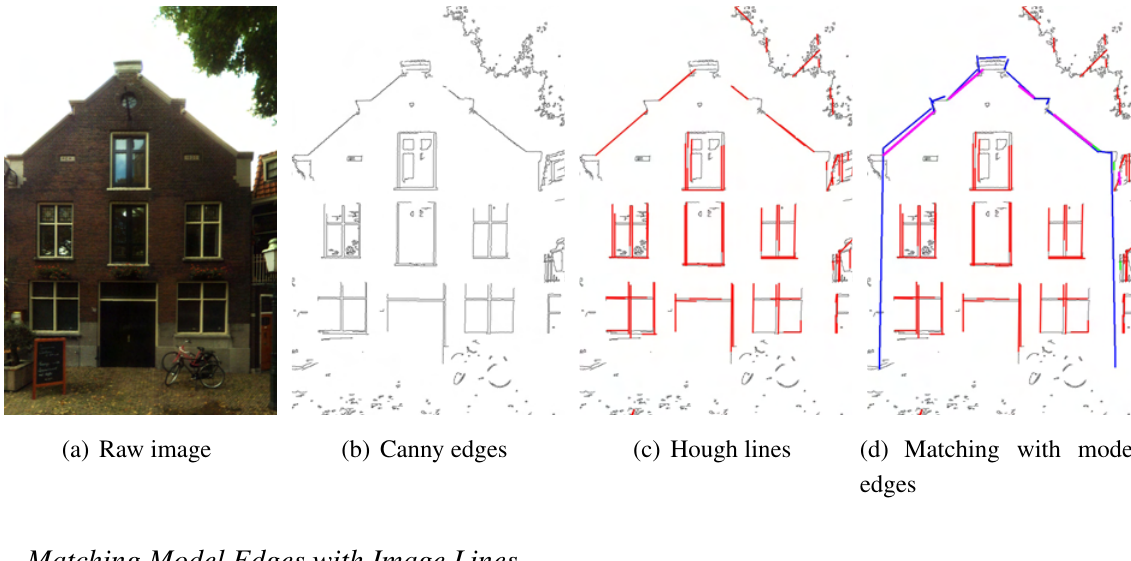
Figure 7. Extracting significant lines from an image (black: Canny edges; red: Hough lines; blue: projections of model edges; green: candidate matches; purple: best